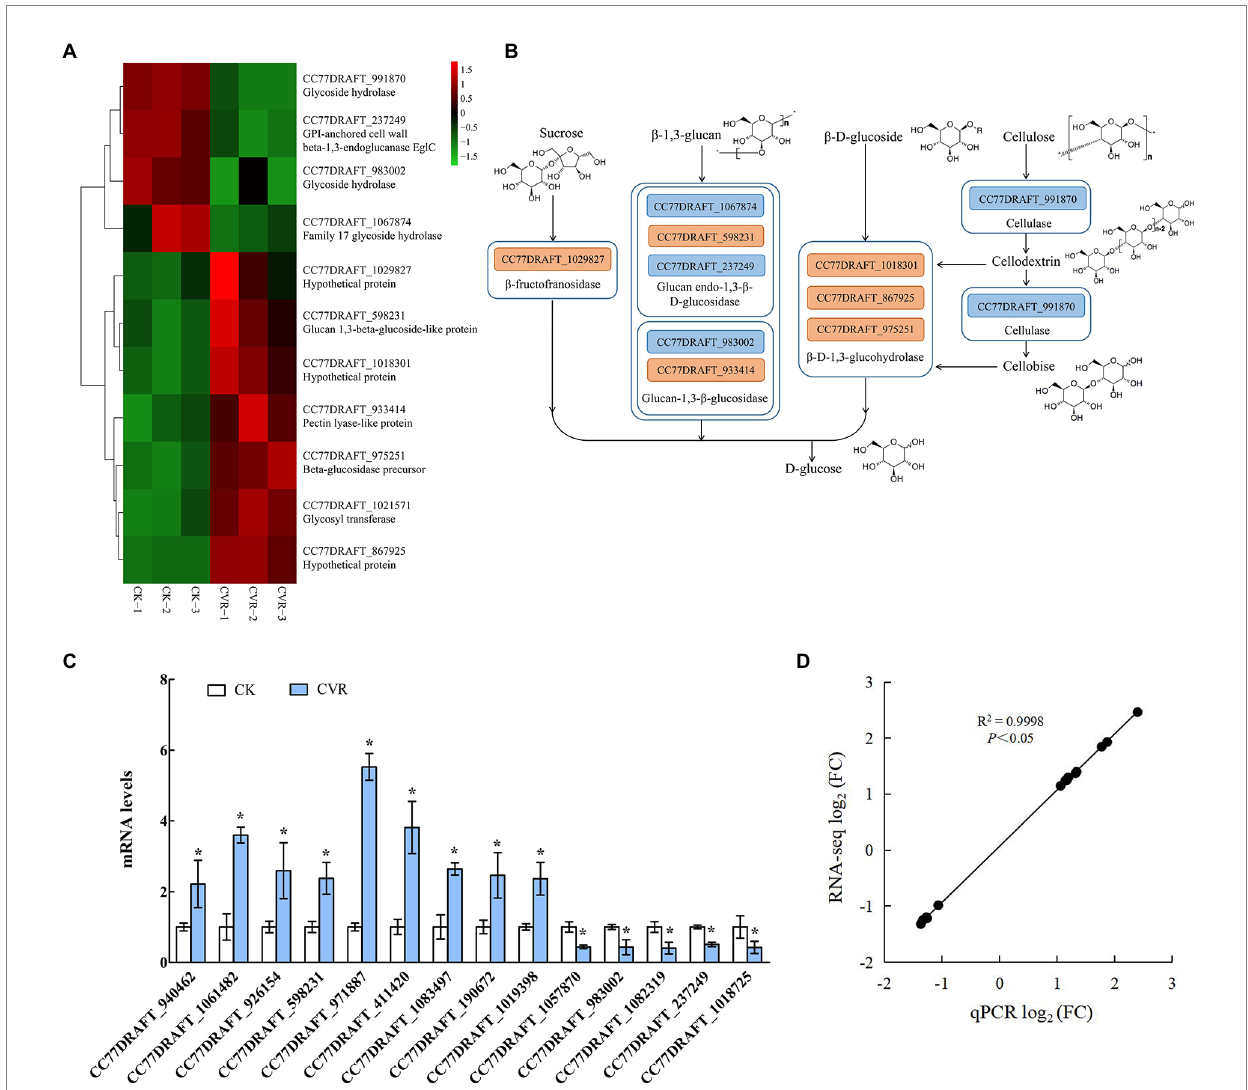
FIGURE 5 RNA-Seq influence of CVR treatment on metabolism of polysaccharide substances. (A) DEGs in sucrose metabolism signaling pathway, (B) Possible mechanism of CVR treatment regulating sucrose metabolism signaling pathway, (C) Relative expression levels of candidate genes by qRT-PCR. The data were analyzed by t -test; * represents significant difference ( p < 0.05), and (D) Correlation between results of qRT-PCR and results of